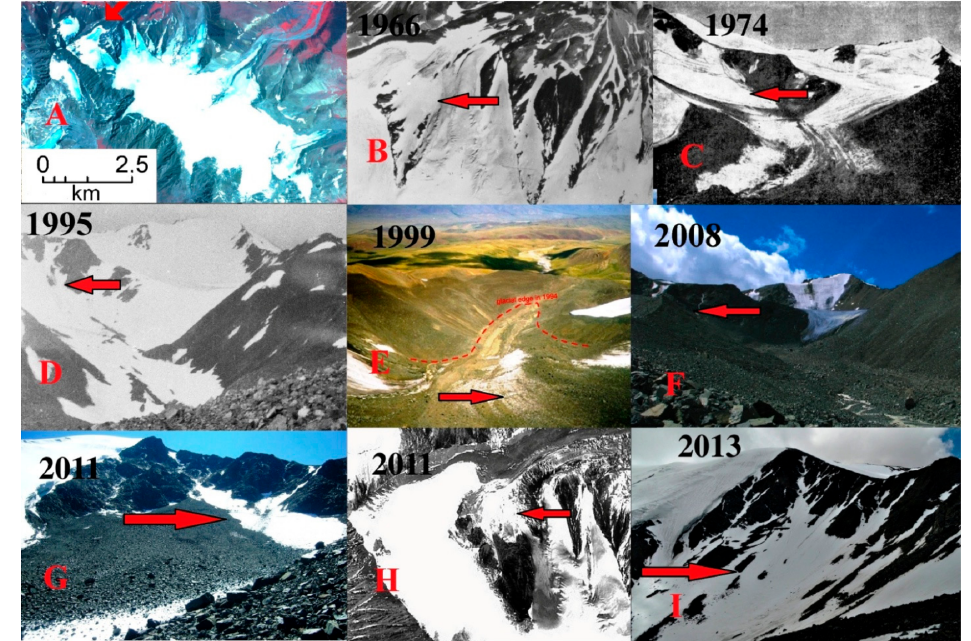
Figure 5. Multiyear changes of the former part of the Left Mugur Glacier (No. 5), the Mongun-Taiga massif. ( A ) A fragment of a SPOT 5 image (2014) with the general view of the main glacial complex of the massif; ( B ) aerial photo (10 July 1966); ( C ) photo by V.S. Revyakin [28] (1974); ( D ) photo by the authors (July 1995); ( E ) photo by the authors (1999/07), the dotted line shows the edge of the glacier in 1994; (F) photo by the authors (24 July 2008); ( G ) photo by the authors (July 2011); ( H ) SPOT 5 satellite image (19 September 2011); ( I ) photo by the authors (9 July 2013). The arrows show the same area of the glacier that was debris-covered after 1995 and started to recover after